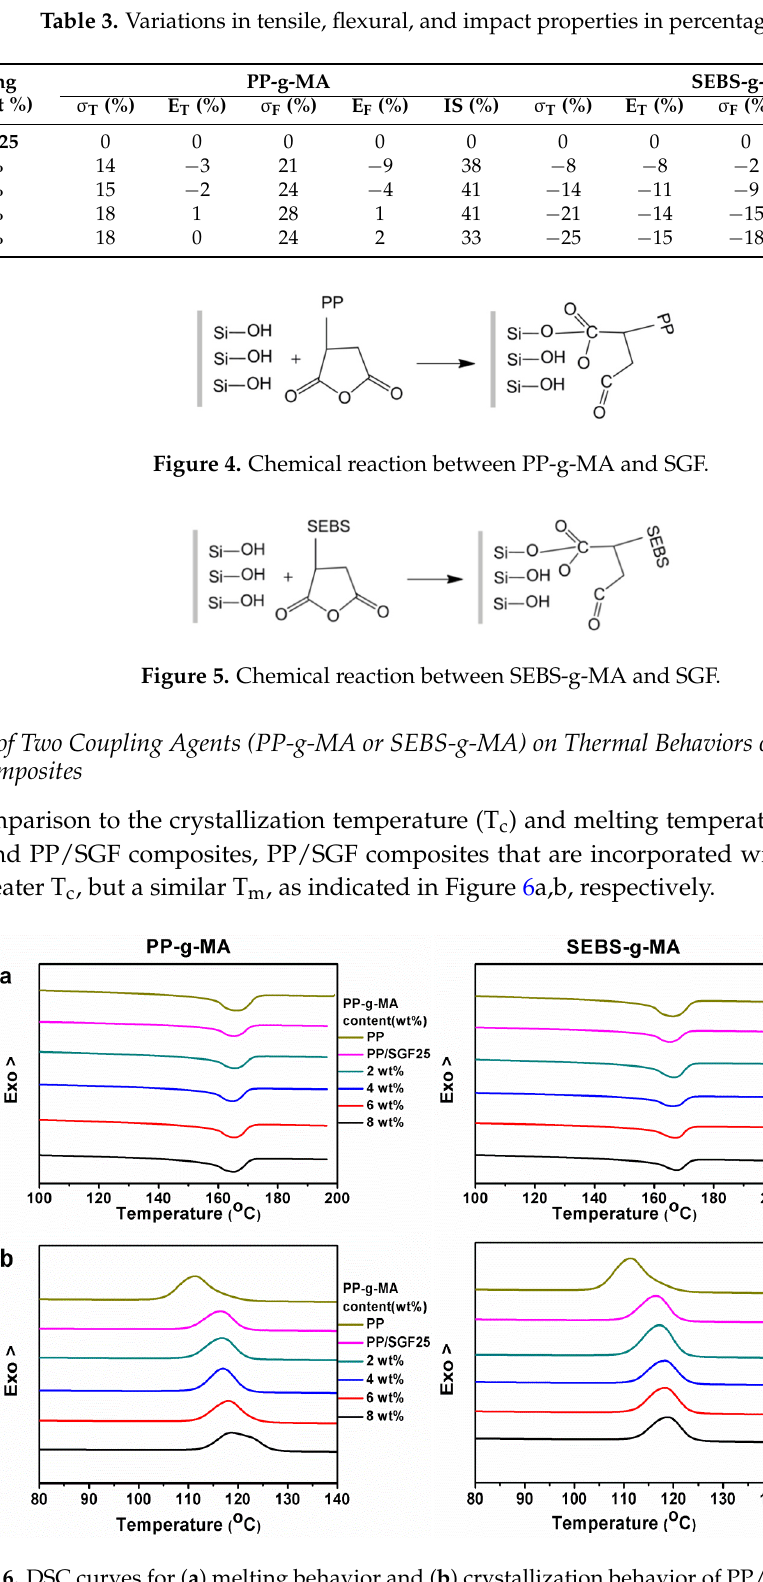
Figure 6. DSC curves for ( a ) melting behavior and ( b ) crystallization behavior of PP/SGF composites.